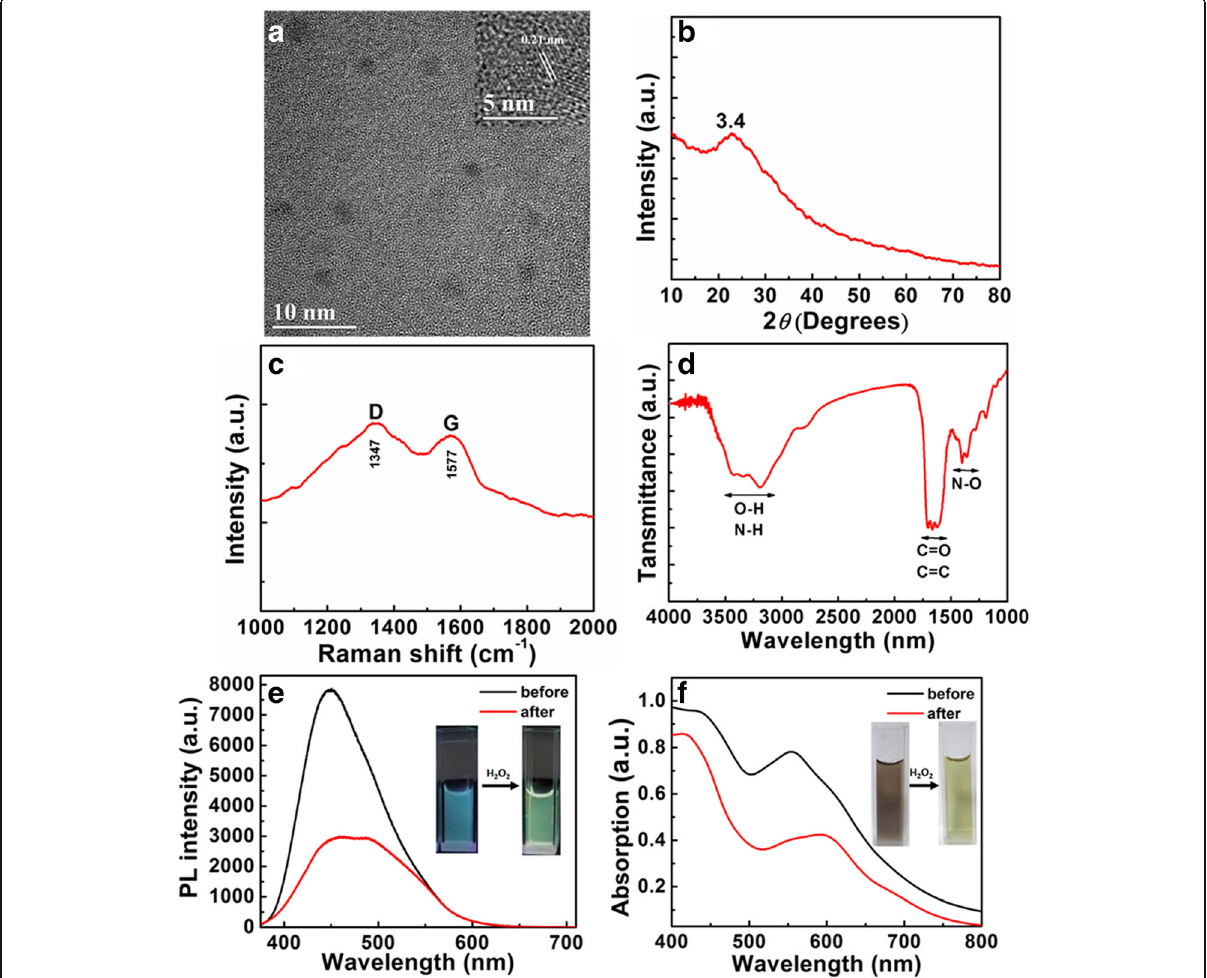
Fig. 1 a TEM image of the CDs. Insets show the HRTEM image of the CDs. b XRD pattern of the CDs. c Raman spectroscopy of the CDs. d FTIR spectroscopy of the CDs. e Fluorescence variation of CDs after adding 0.5 M H 2 O 2 . Insets show photographs of CDs before ( left ) and after ( right ) adding the H 2 O 2 under UV light. f Colorimetric variation of CDs after adding 0.5 M H 2 O 2 . Insets show photographs of CDs before ( left ) and after ( right ) adding the